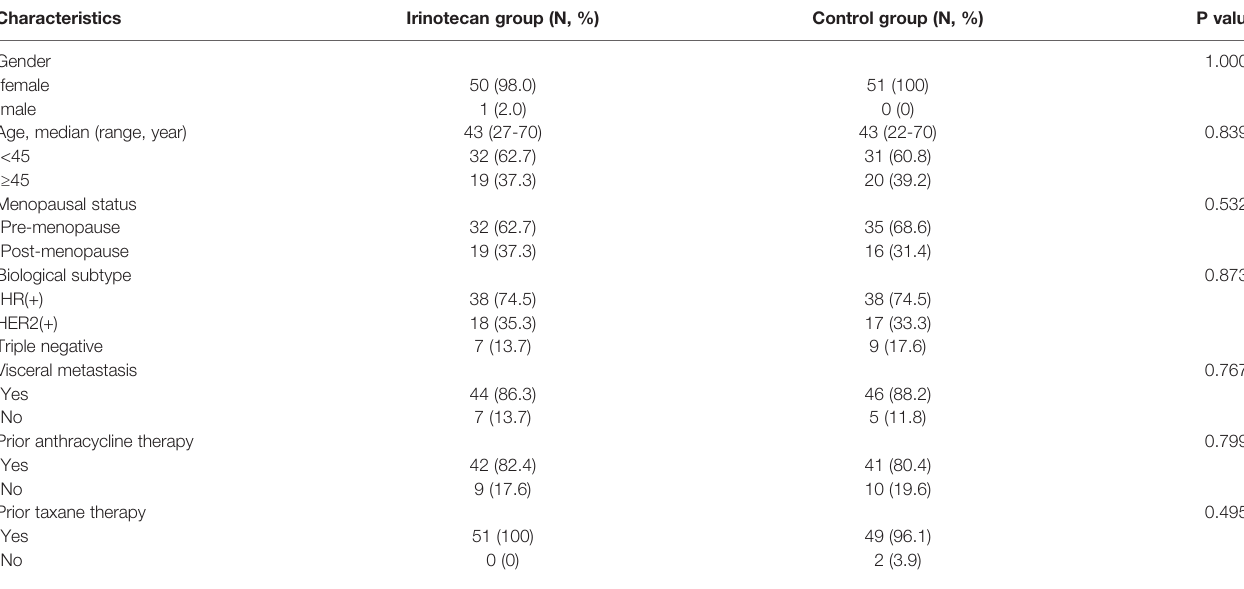
TABLE 2 | The baseline patient characteristics.